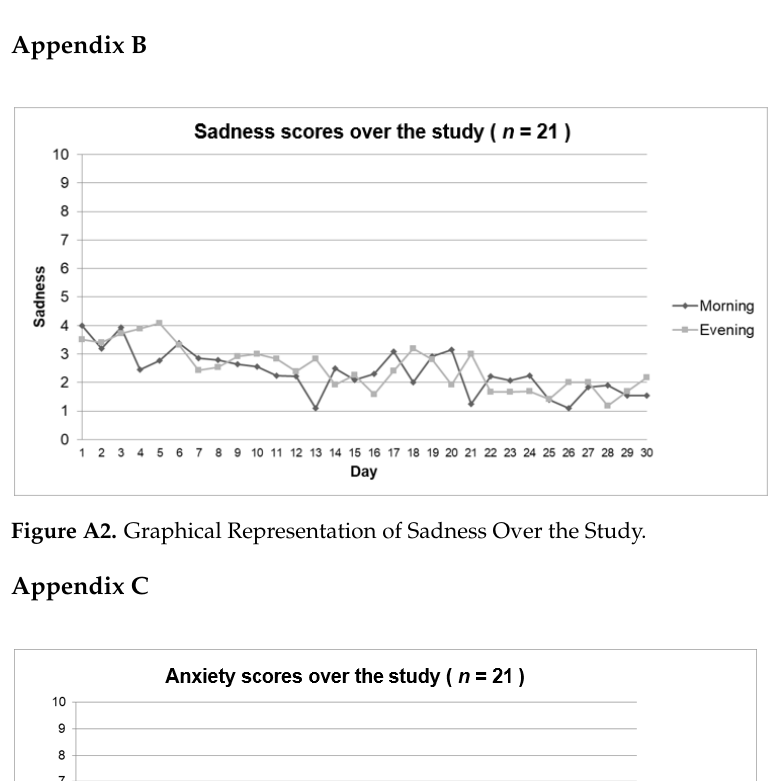
Figure A1. Graphical Representation of Happiness Over the Study.